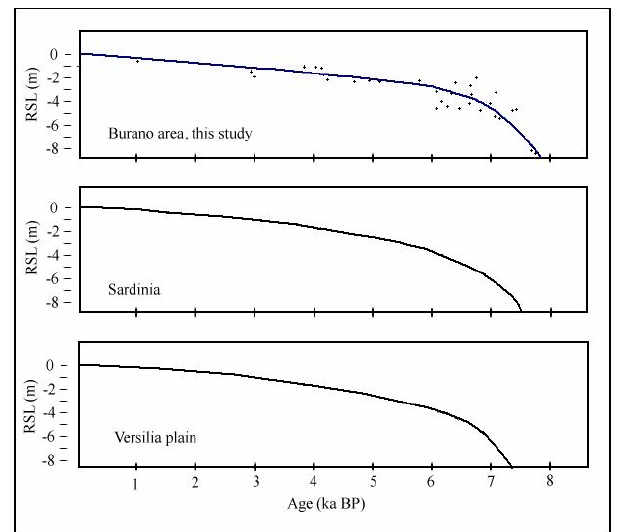
Figure 7. Comparison between the Burano RSL curve and the curves for Sardinia and Versilia plain modified from [88,89].